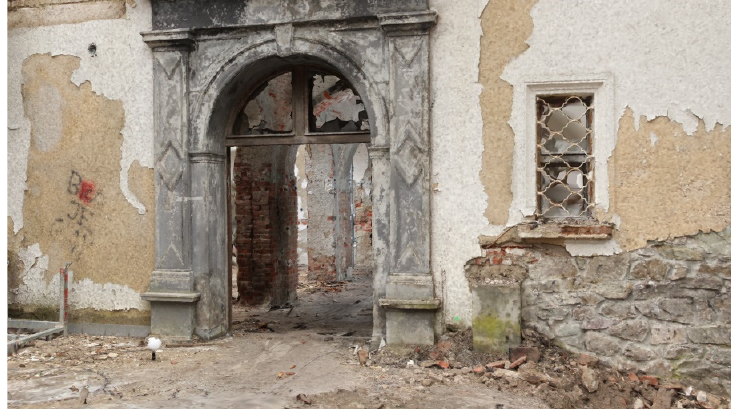
Figure 7. Detail from terrestrial (ground)